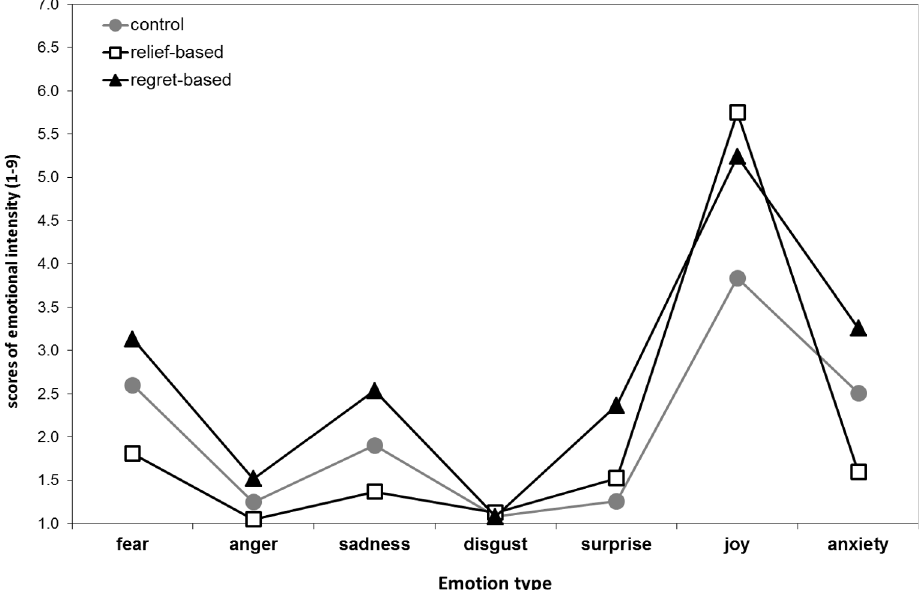
Fig 2. Emotions. Intensity of the emotions experienced after the reading of each narrative as a function of narrative type, independent of the narrative emotion group (with or with no expressed emotions).